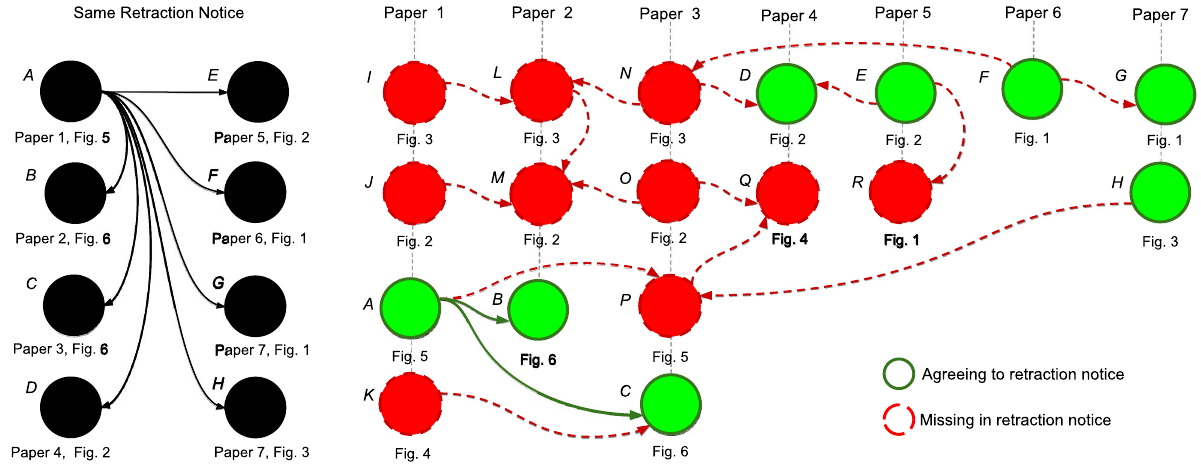
Figure 7. Result example of provenance analysis applied over a particular case of inadvertent image reuse across seven different papers, which are part of the SP dataset. In ( a ), the provided annotation (ground-truth provenance graph), obtained through a manual curation of the content of the retraction notice available under DOI https:// doi. org/ 10. 1371/ journ al. pone. 01905 62. According to this document, Fig. 5 from Paper 1 (node A ) shares elements with other seven figures coming from six distinct papers (herein represented by nodes B - H ). In ( b ), the resulting provenance graph computed by SILA. Besides finding the expected images of nodes A - H (highlighted in green, to show agreement with the retraction notice), SILA also encountered other ten figures presenting evidence of content sharing (represented by nodes I - R and herein highlighted in dashed red, to indicate absence in the retraction